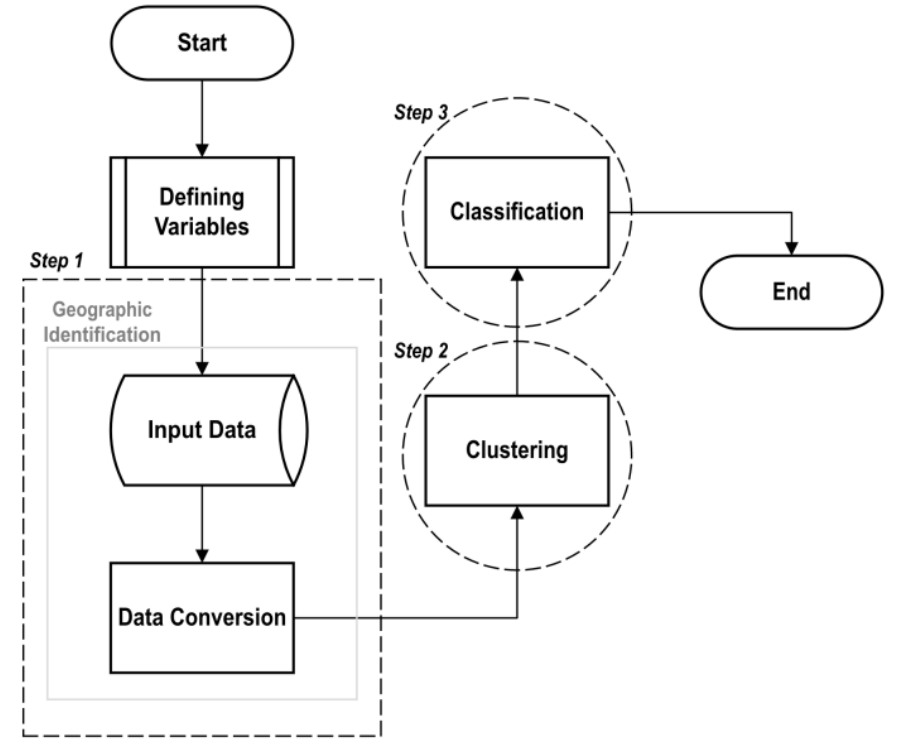
Figure 2. Diagram of the proposed platform — clustering and classification model.